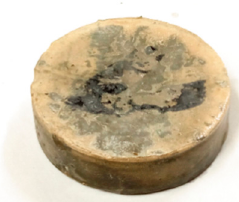
Figure 5. Disc-shaped samples were used to check thermal conductivity (photo by K. Se ń